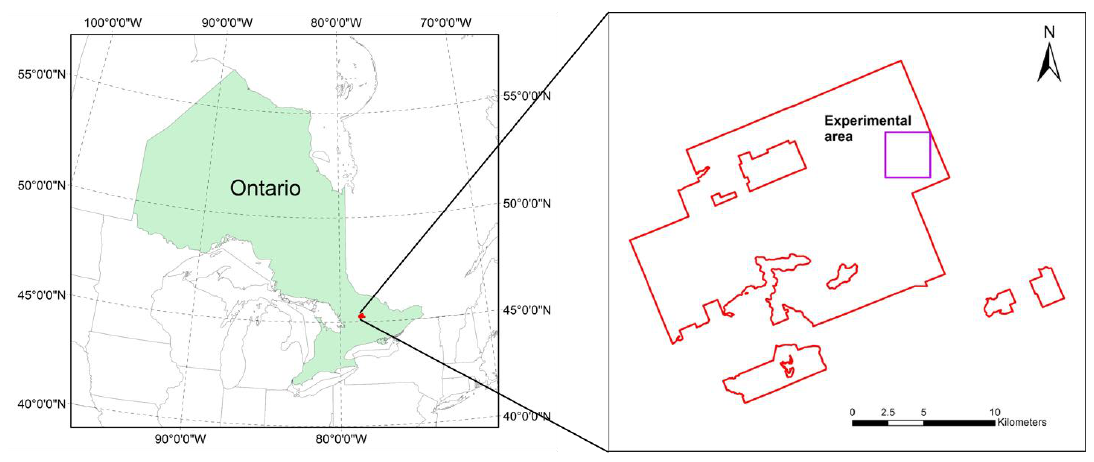
Figure 1. Location of the experimental site in Haliburton Forest and Wildlife Reserve, Ontario, Canada.